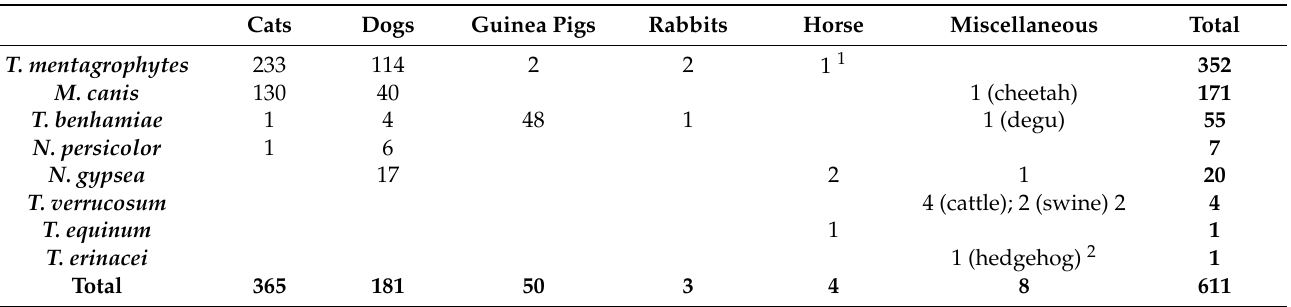
Table 2. Dermatophytes isolated in Lausanne from animal samples collected by veterinarians between 2008 and